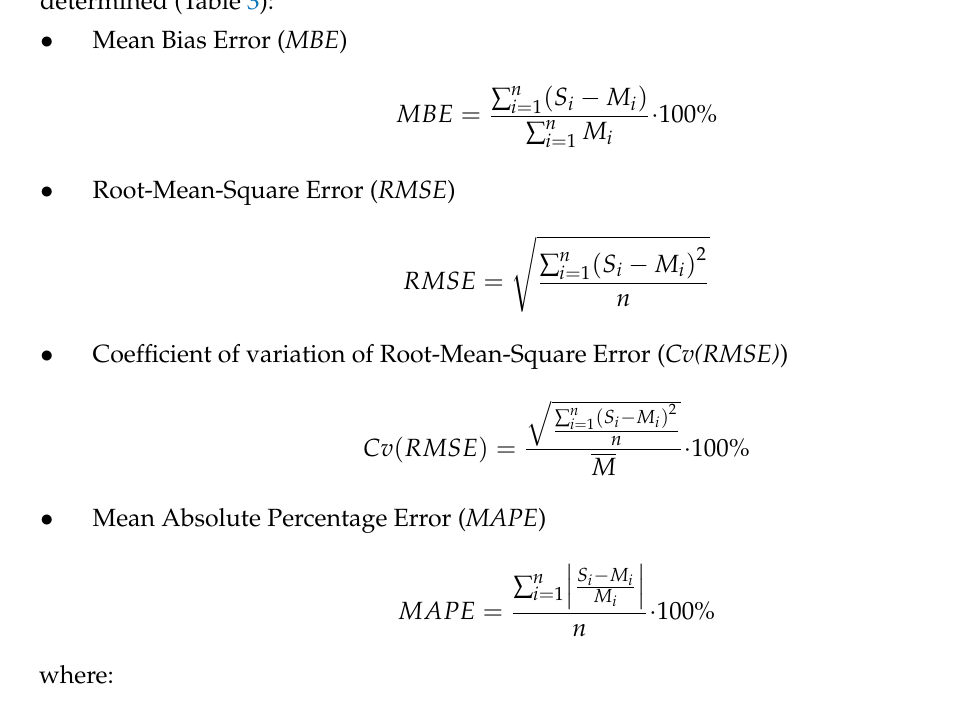
Figure 5. Temperature time series coming from measurements and simulations, 18 May 2016–9 June 2016.